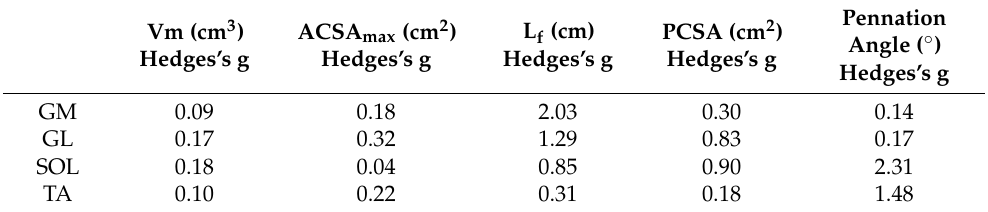
Table 2. Corrected effect sizes (Hedges’s g) of the changes reported in Table 1 regarding the architec- tural parameters from the GM, GL, SOL and TA